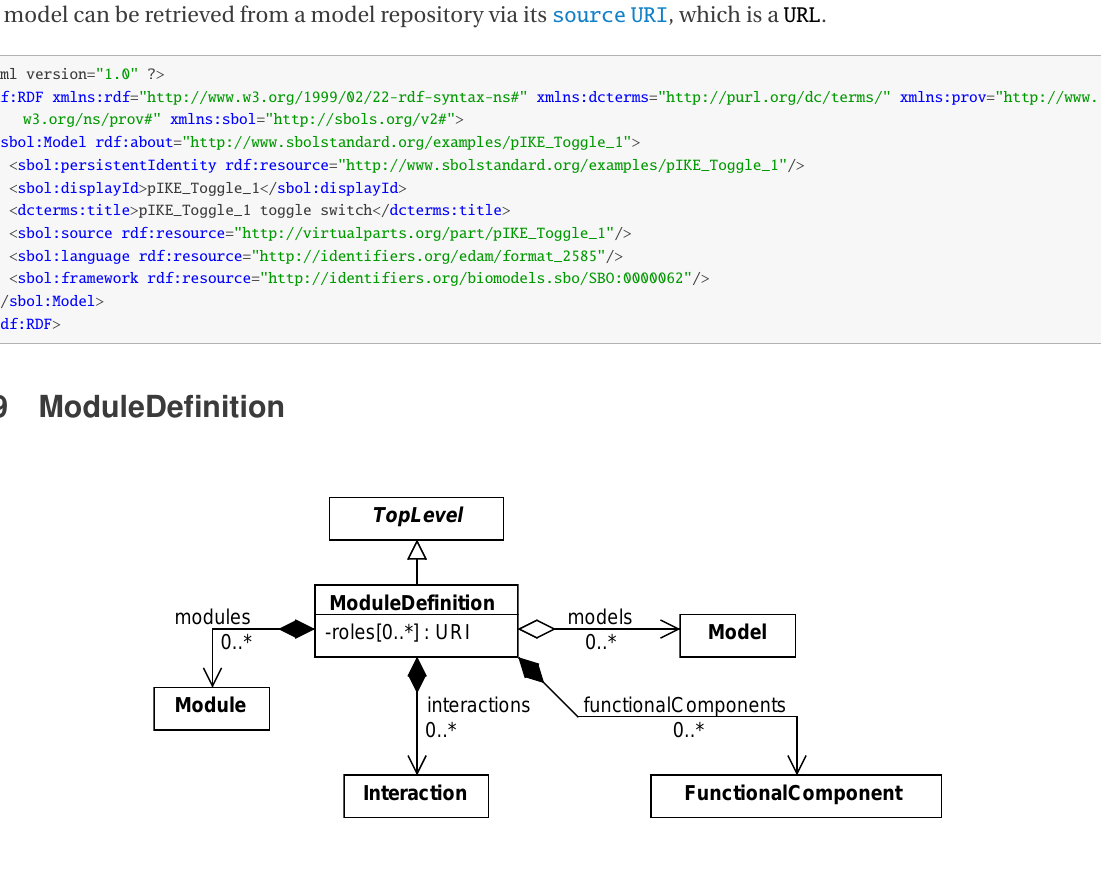
Figure 15: Diagram of the ModuleDefinition class and its associated